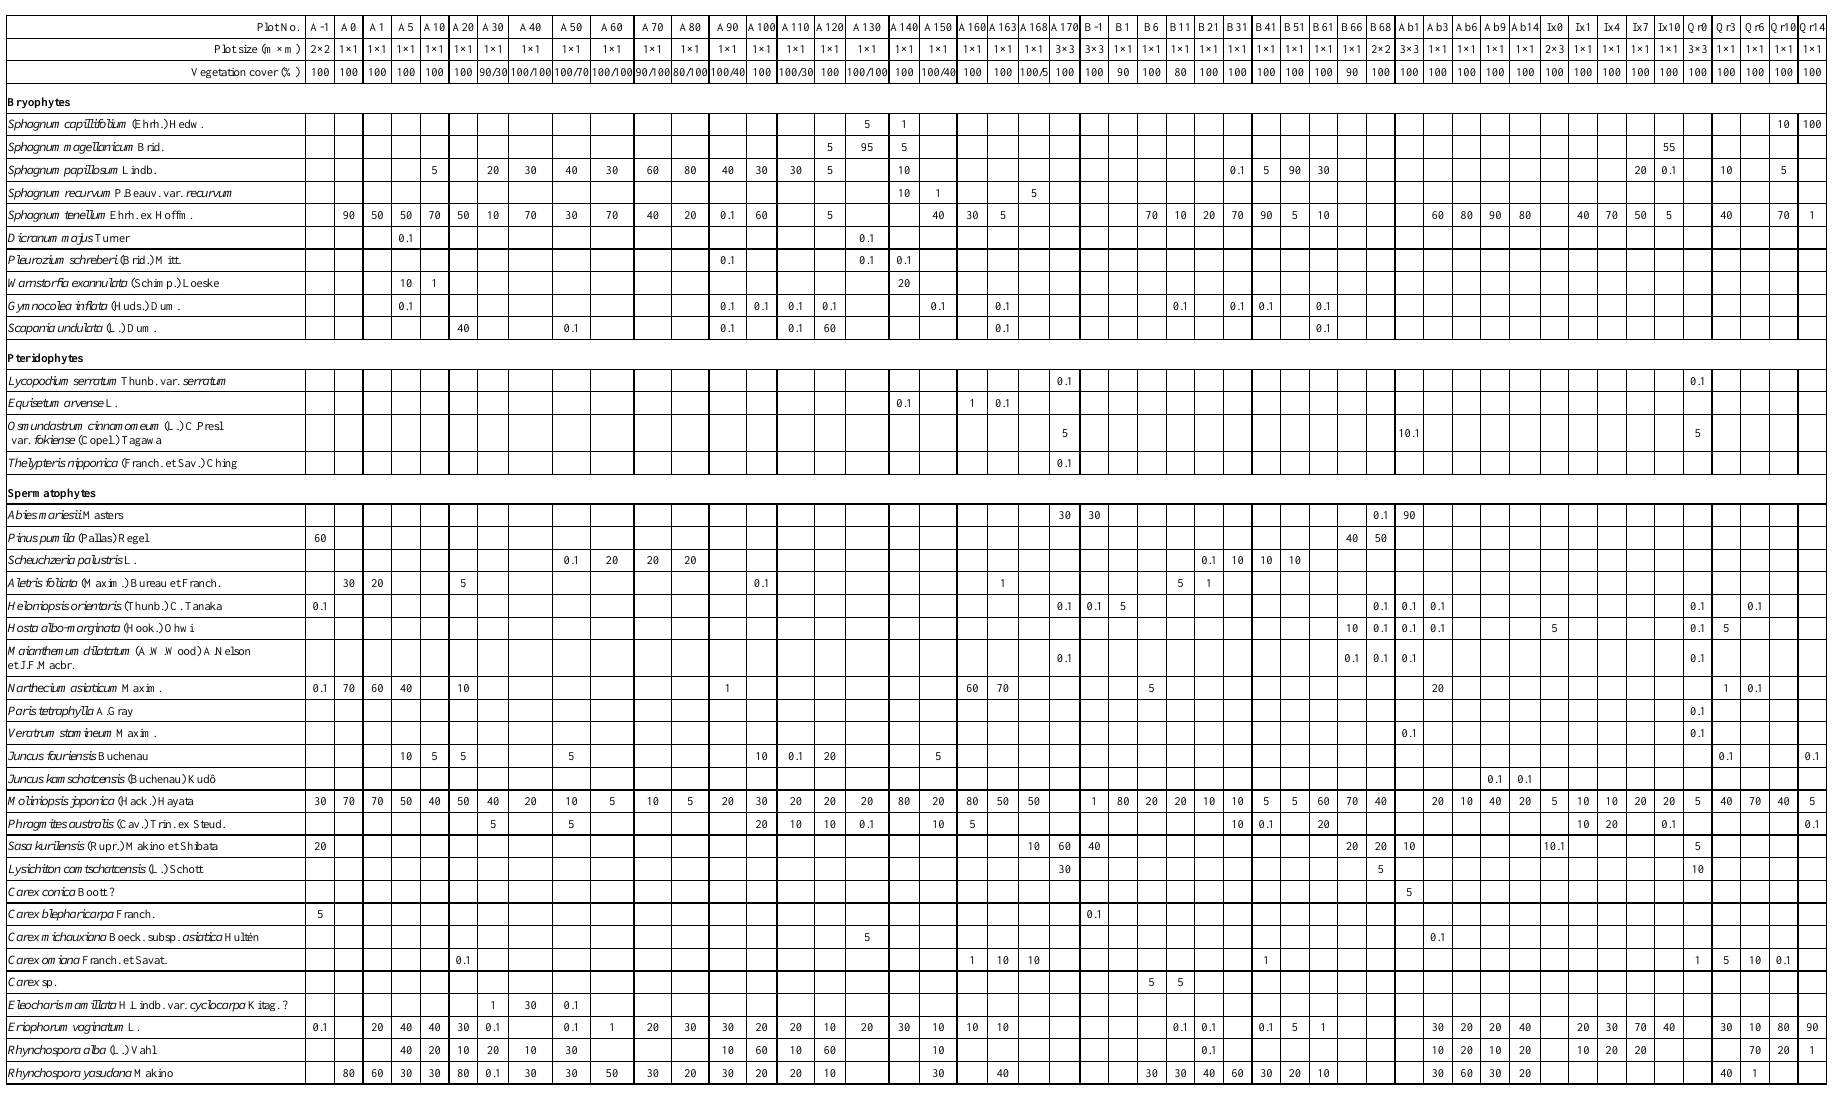
Table A3. Species composition of the plots in Takada-yachi Mire. The extent of species dominance is shown as original percent